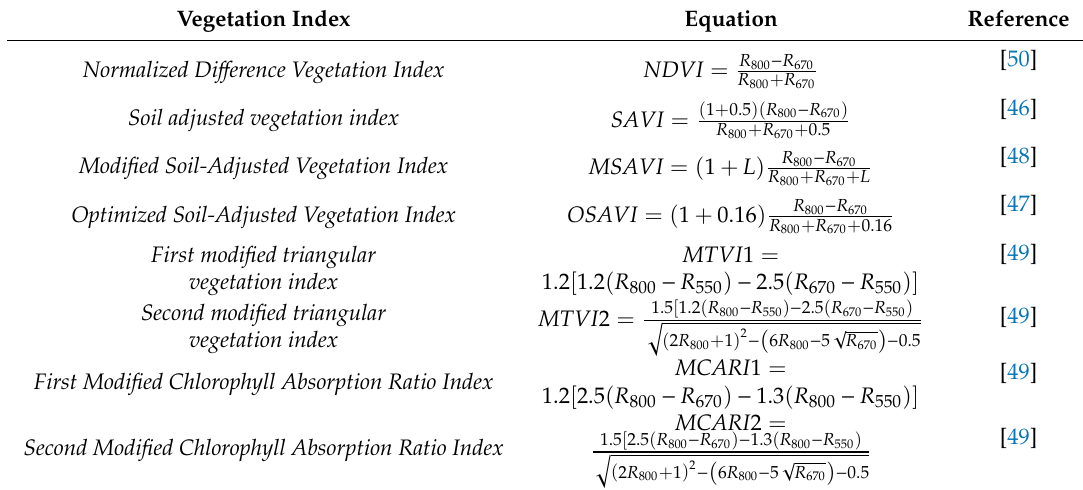
Table 3. Vegetation Indices included in this study and their formulations. R refers to reflectance and the sub-indices indicate the value of the central wavelength in